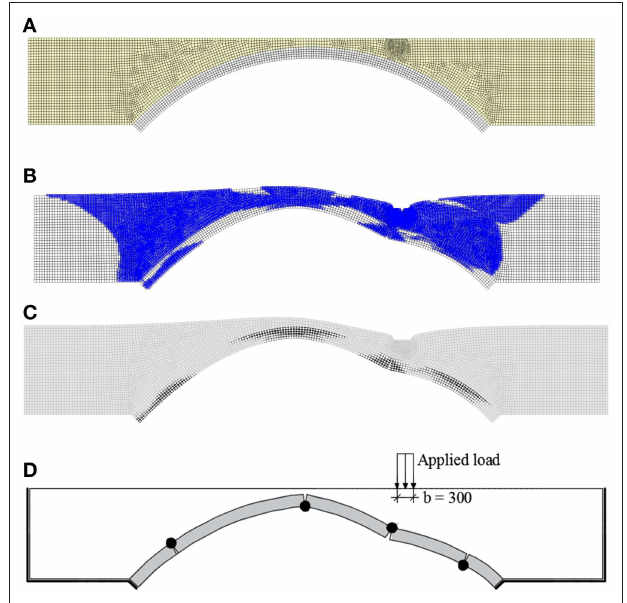
FIGURE 8 | (A) Model mesh discretization; (B) plastic zones contour at ultimate load; (C) cracking pattern contour at ultimate load condition; (D) Prestwood bridge: Experimental collapse mechanism.